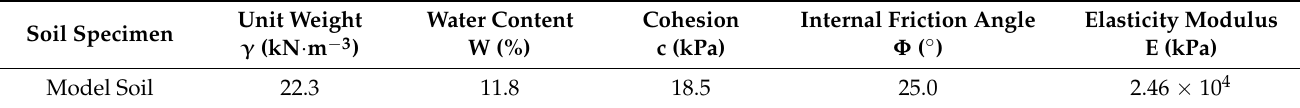
Table 2. Main mechanical indexes of soil specimens.